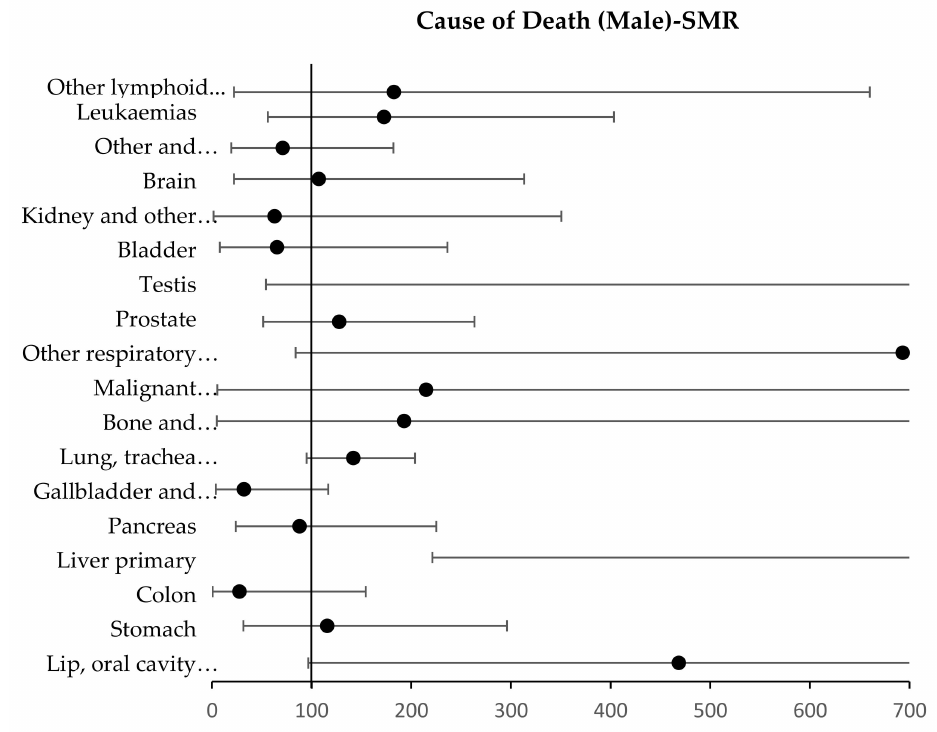
Figure 5. Forest plot of observed male deaths by cancer type (SMR). An SMR < 100 indicates fewer than expected deaths. An SMR = 100 indicates observed deaths equal expected deaths. An SMR > 100 indicates there were excess